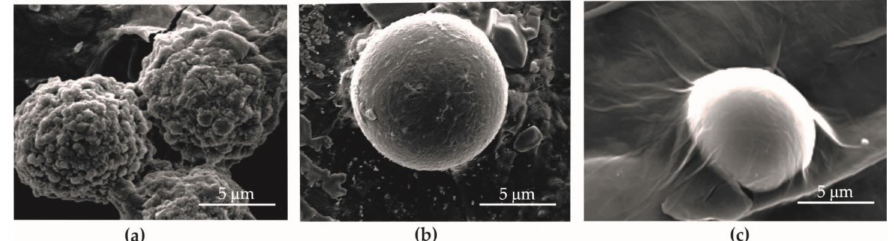
Figure 9. SEM images in variant I of MDA-MB-231 cancer cells with GO deposited on: ( a ) living cells and ( b , c )